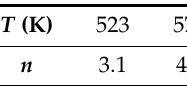
Figure 11. Linear fitting of nano-SiCp/AZ91 composite: ( a ) ln ε(cid:4662) − ln σ , ( b ) ln ε (cid:4662) − σ , ( c ) ε(cid:4662) − ln (sinh( α (cid:2026) )), ( d ) ln(sinh( α (cid:2026) )) − 1/ T . Table 4. The n values of nano-SiCp/AZ91 composite.